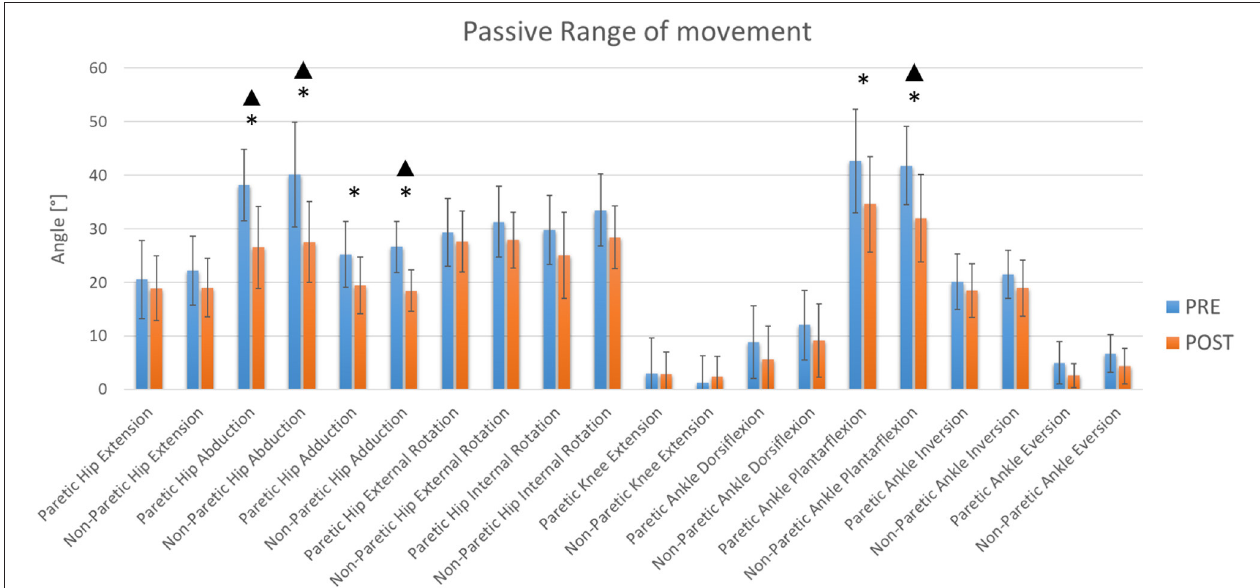
FIGURE 5 | Lower limbs PROM. The blue and orange bars show the mean value (M). The standard deviation (SD) is also shown through error bars. *Significant differences. N Statistical power > 80%.